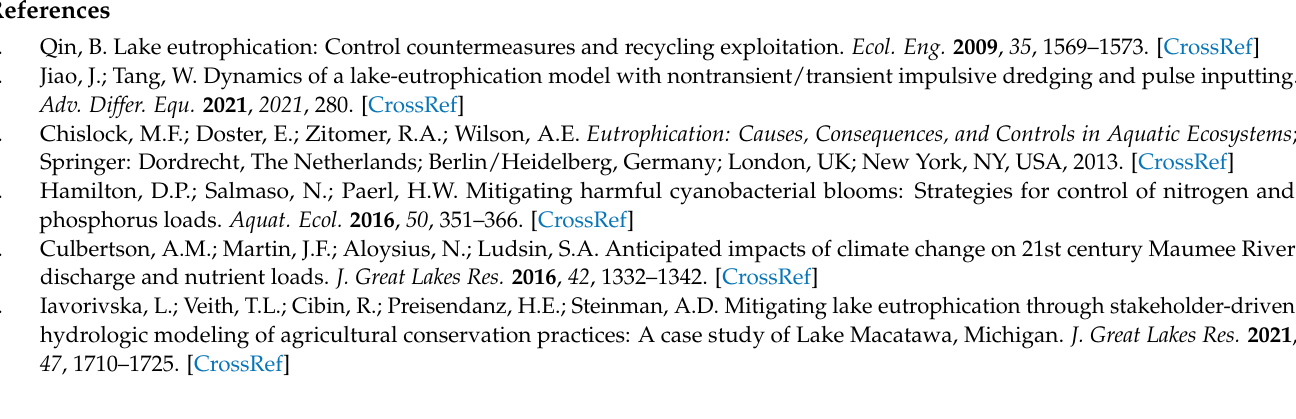
planting structure in the North of Erhai Lake